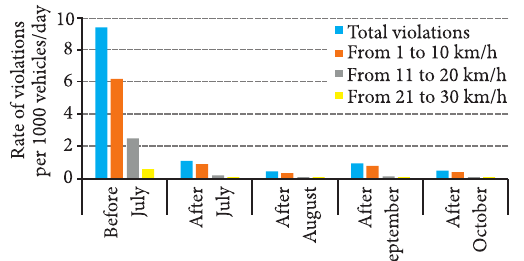
Fig. 3. Violations number of permissible average 88 km/h speed before-after system installation